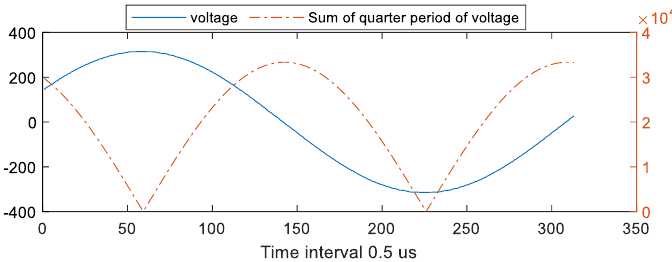
Figure 10. Using the sum of the quarter to find the initial integration position of pure sine wave.